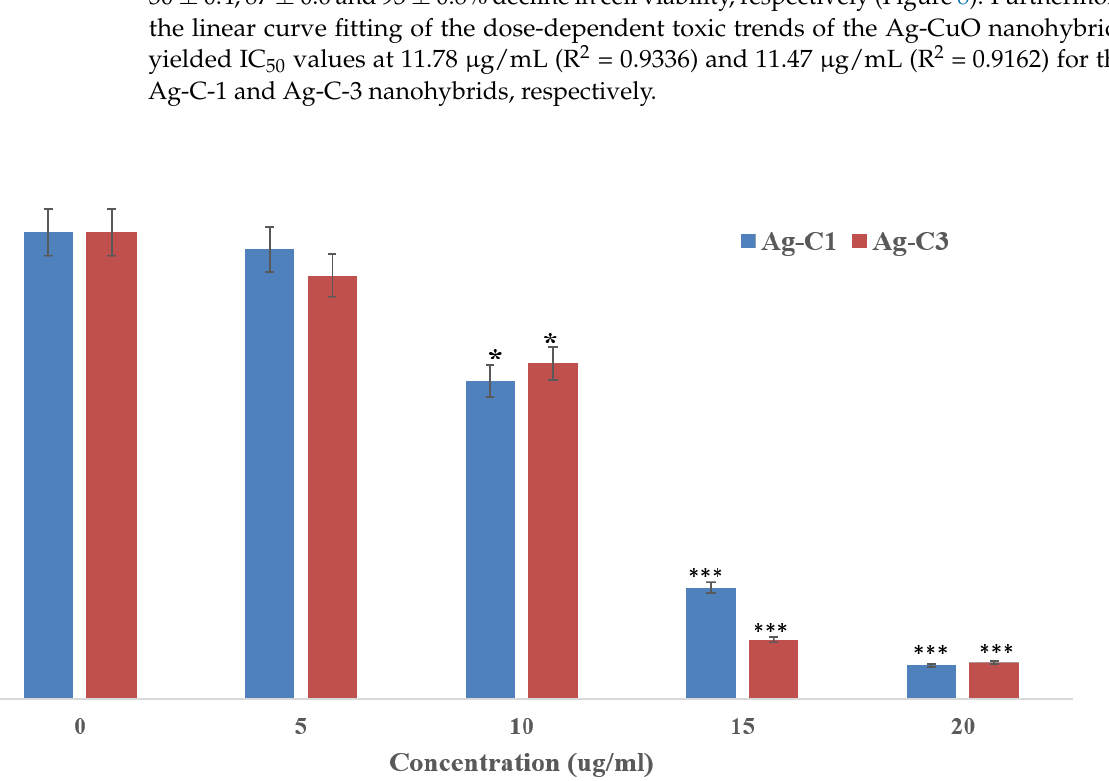
Figure 9. MTT assay showing percent cell viability of the HCT-116 cells after treatment at different concentration of Ag-C-1 and Ag-C-3. * p < 0.05, *** p < concentration of Ag-C-1 and Ag-C-3. * p < 0.05, *** p < 0.001.